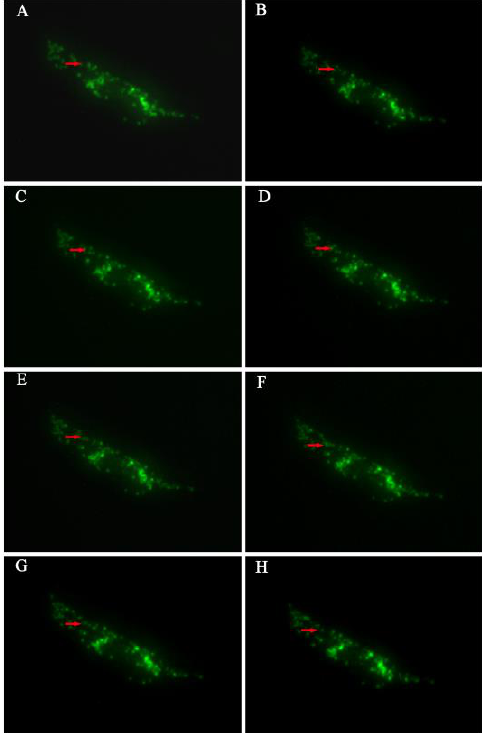
Figure 3. Movement of hTMEM59 in living C17.2 cells following interval photographs. ( A – H ) Punctuated fluorescent signals in the neurite and the cytoplasm, whereas the fluorescent signals also appeared dense and clustered in the perinuclear regions.